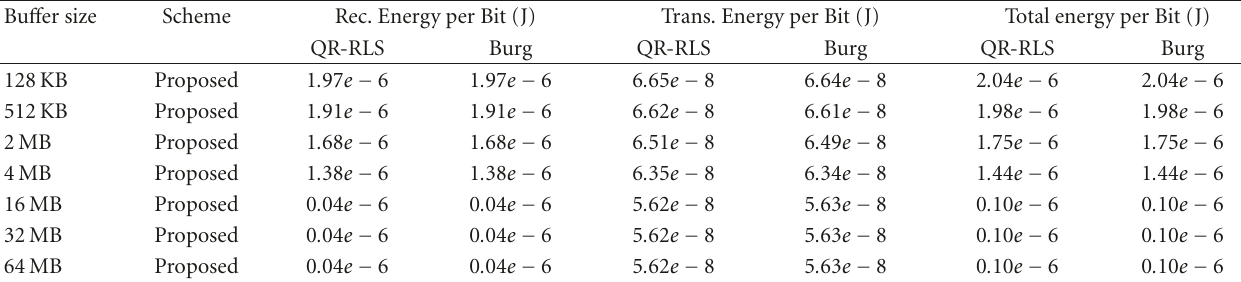
Table 8: Performance comparison for di ff erent channel prediction algorithms for Stream 1 ( d = 15 m).